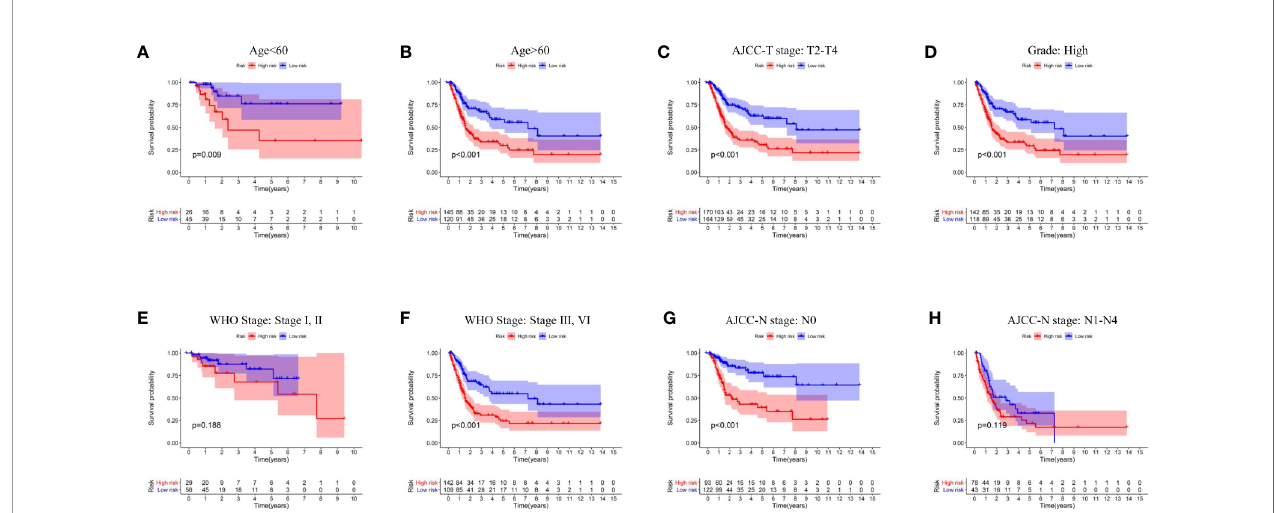
FIGURE 4 | Kaplan – Meier curves analyses of clinical subgroups in TCGA cohort (A) Age < 60 years, (B) Age > 65 years, (C) AJCC-T stage: T2-T4, (D) Grade: High, (E) WHO Stage: Stage I, II, (F) WHO Stage: Stage III, VI, (G) AJCC-N stage: N0, (H) AJCC-N stage: N1 – N4. WHO, World Health Organization; AJCC, American Joint Committee on Cancer.